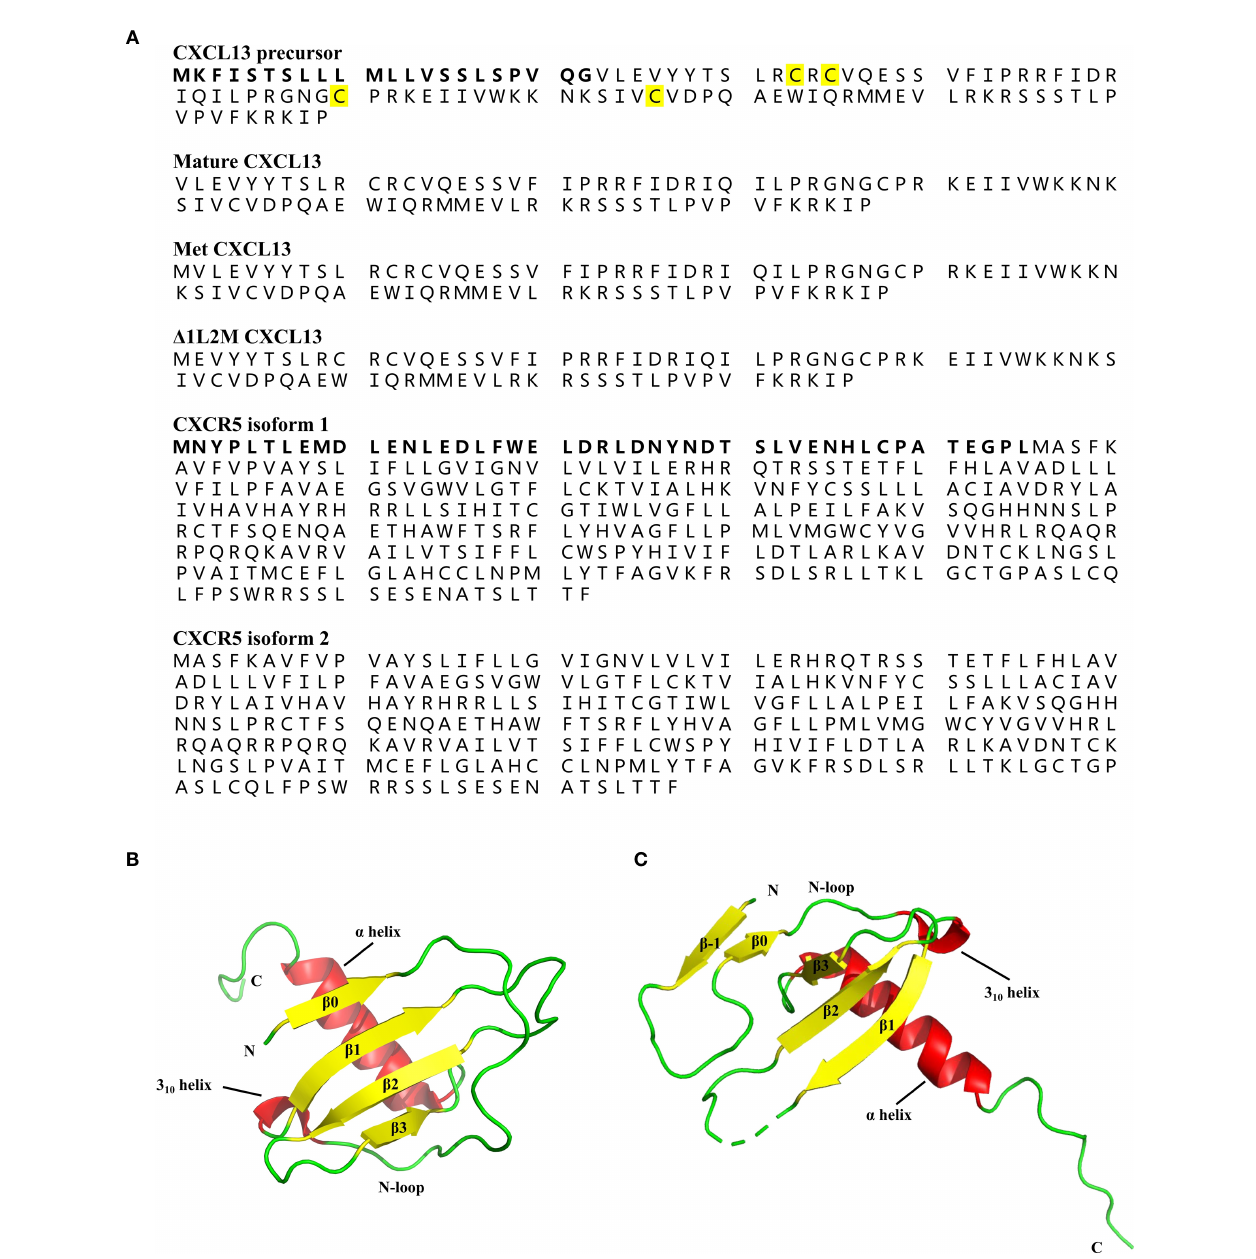
FIGURE 3 | Protein structures of CXCL13 and CXCR5. (A) The amino acid sequence of human CXCL13 precursor, mature CXCL13, Met CXCL13, D 1L2M CXCL13, and two isoforms of human CXCR5. The human CXCL13 protein consists of 109 amino acids, including a signal peptide of 22 amino acids (marked in bold). The four conserved cysteine residues are marked in yellow. The human CXCR5 has two isoforms due to the alternatively spliced transcript variants. The difference between the two isoform of CXCR5 is additionally marked in bold. (B) The tertiary structure of Met CXCL13 [Protein Data Bank (PDB) ID: 7JNY]. The N- terminus of Met CXCL13 forms a b 0-sheet, followed by a long N-loop ending in a short 3 10 -helix, and the central three-stranded anti-parallel b -sheet, and a C- terminal a -helix. b -sheet is indicated by yellow arrows, and a -helix and 3 10 -helix are indicated by red cylinders. (C) The tertiary structure of D 1L2M CXCL13 monomer [PDB ID: 6VGJ]. In D 1L2M CXCL13, the N-terminus folds into a b -strand ( b -1), followed by a b 0-sheet, and a canonical chemokine core domain. b -sheet is indicated by yellow arrows, and a -helix and 3 10 -helix are indicated by red